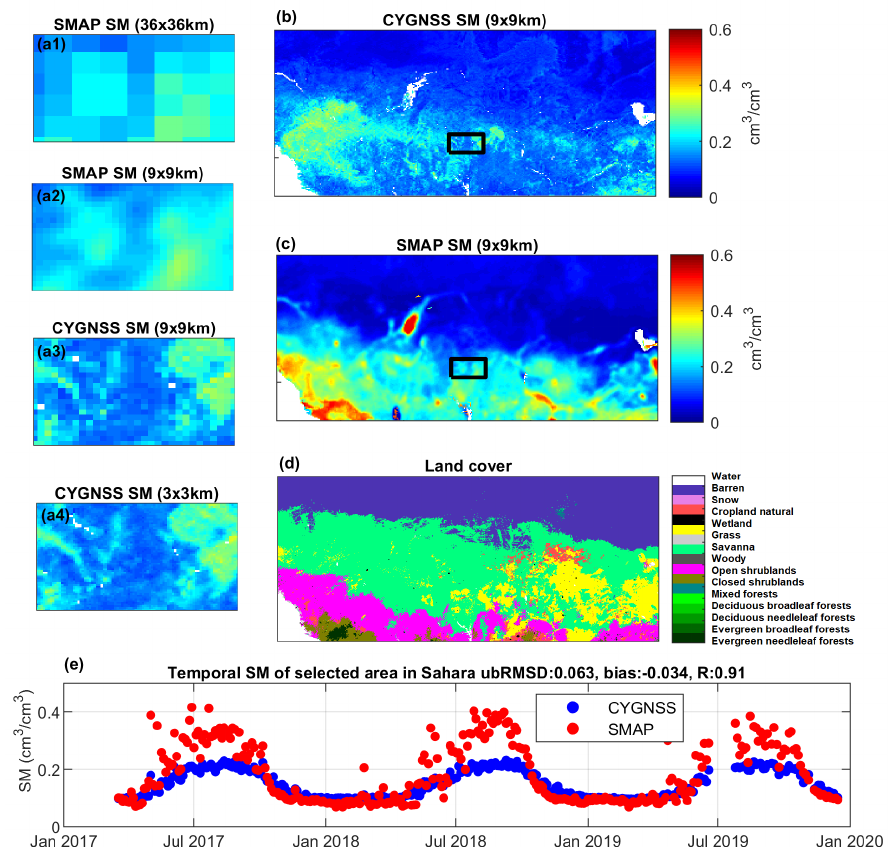
Figure 12. Averaged SM predictions for Sahara during Oct 2018. ( a ) Detailed images of selected area for SMAP 9-km and 36-km and CYGNSS 3-km and 9-km, ( b ) CYGNSS 9-km, ( c ) SMAP 9-km, ( d ) land cover map, and ( e ) a time-series example from selected area.